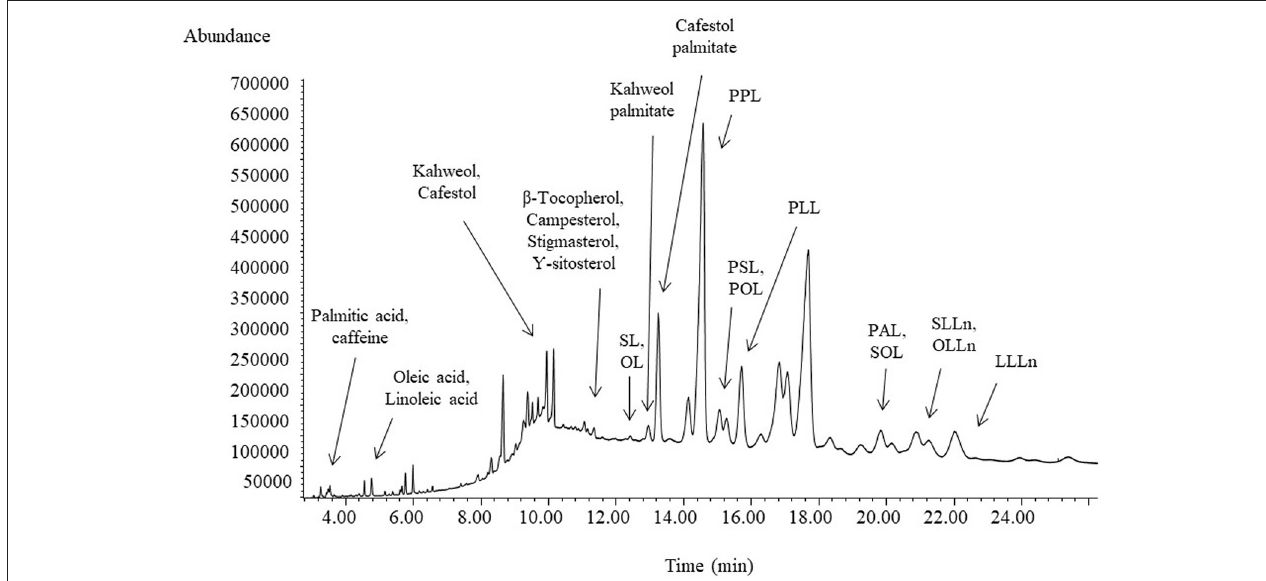
FIGURE 4 | Typical chromatogram of the crude lipid fraction from Kopi Luwak coffee samples. Dashed lines indicate regions of fatty acids, caffeine, free diterpenes, tocopherols and sterols, diacylglycerols, esterified diterpenes and triacylglycerols. P, palmitic; O, oleic; L, linoleic; S, stearic; A, arachidonic; Ln, linoleic.